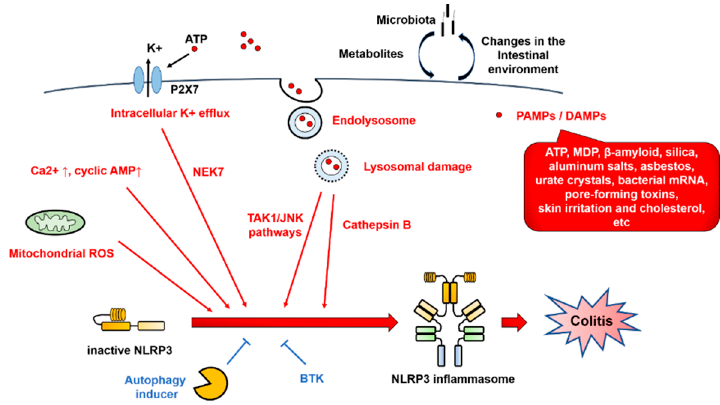
Figure 4. NOD-like receptor family pyrin domain-containing 3 (NLRP3) inflammasome regulators. NLRP3 inflammasome activation involves various types of pathogen-associated molecular patterns (PAMPs) or danger-associated molecular patterns (DAMPs), such as ATP, muramyl dipeptide (MDP), β -amyloid, silica, asbestos, urate crystals, bacterial mRNA, pore-forming toxins, skin irritants, and cholesterol. In addition, the major mechanistic pathways and stimuli that trigger NLRP3 inflammasome activation have been reported to include intracellular K + efflux, mitochondrial reactive oxygen species (ROS), and lysosomal damage. Red arrows indicate activation of NLRP3 inflammasome. Blue T-shaped lines indicate inhibition of NLRP3 inflammasome activation. BTK, Bruton’s tyrosine kinase; DAMPs, danger-associated molecular patterns; JNK, c-Jun N-terminal kinase; MDP, muramyl dipeptide; NEK7, NIMA-related kinase 7; NLRP3, NOD-like receptor family pyrin domain-containing 3; PAMPs, pathogen-associated molecular patterns; ROS, reactive oxygen species; TAK1, TGF- β -activated kinase 1.